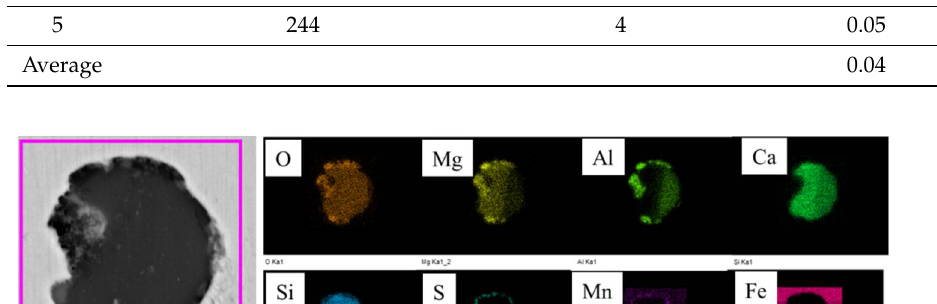
Figure 16. Morphology and composition of typical inclusions in billet.